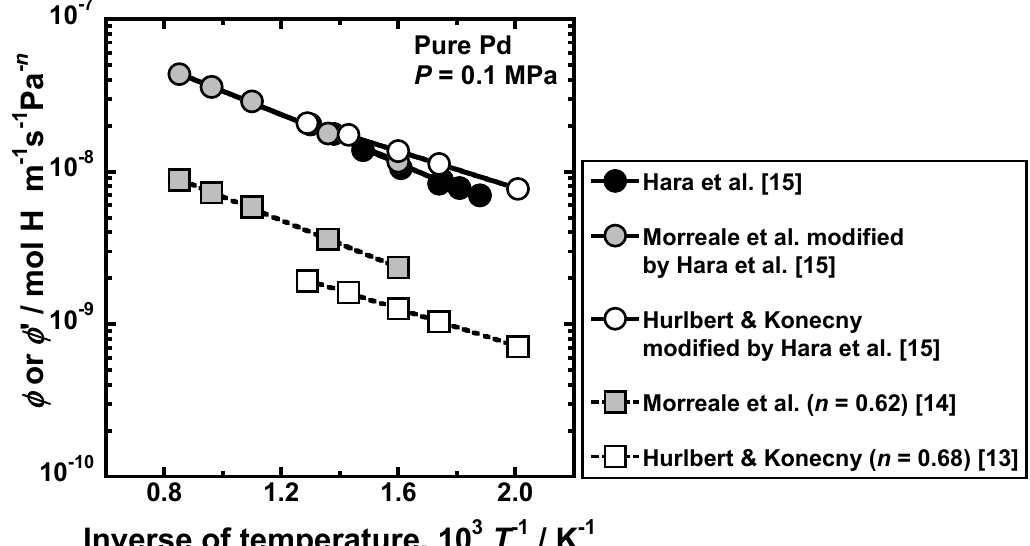
Figure 8. Arrhenius plot of the hydrogen permeation coefficient for the power law reported in the literature [13,14] and the pressure-dependent hydrogen permeation coefficient at 0.1 MPa [15].